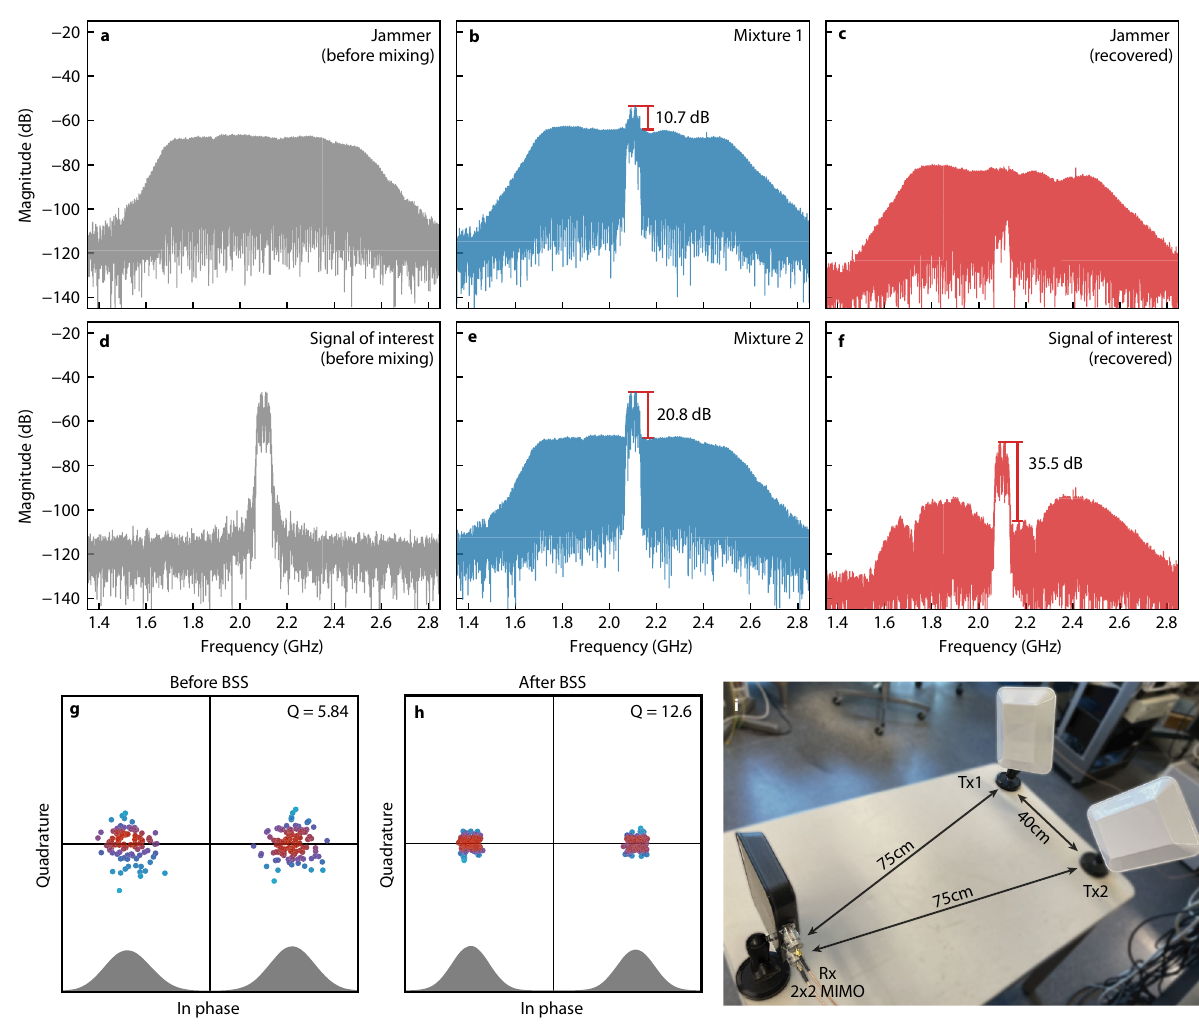
Fig. 3 | BSS demonstration on wireless transceiver system. a , d Spectrum of the source (Tx1)and the jammer (Tx2). These were measured at the receiver whenone of the two transmitters (Tx1 or Tx2) was tuned off. b , e Spectrum of received mixtures. c Spectrumoftheseparatedjammingnoise. f Spectrumoftherecovered